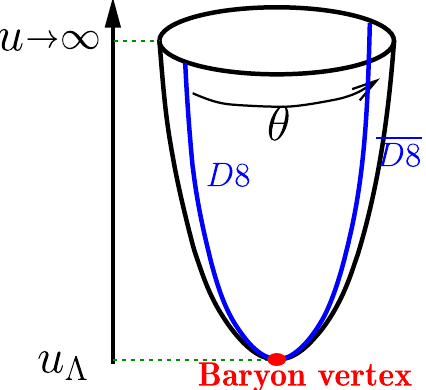
Fig. 5 A sketch of the confined geometry and the setup for flavors branes in the Witten–Sakai–Sugimoto